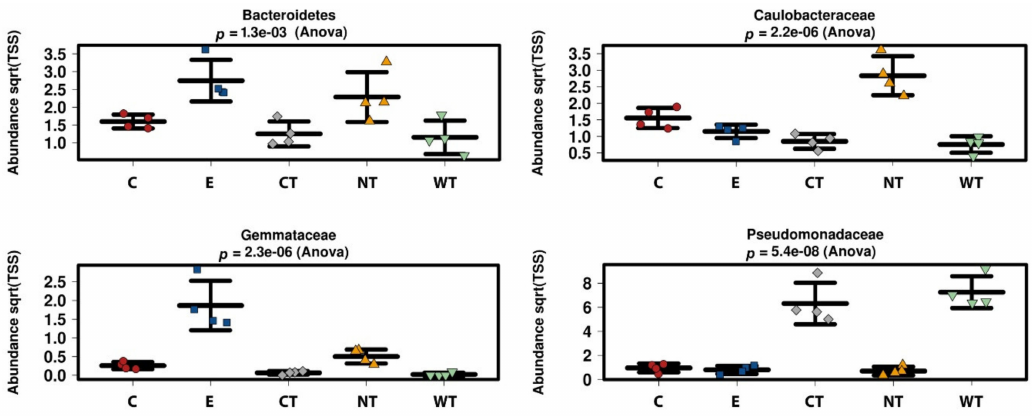
Figure 3. Boxplots showing the relative abundance of selected bacterial taxa identified as biomarkers in the LEfSe analysis. (C: cinnamon; E: ethanol; CT: common thyme; NT: not-treated control; WT: wild